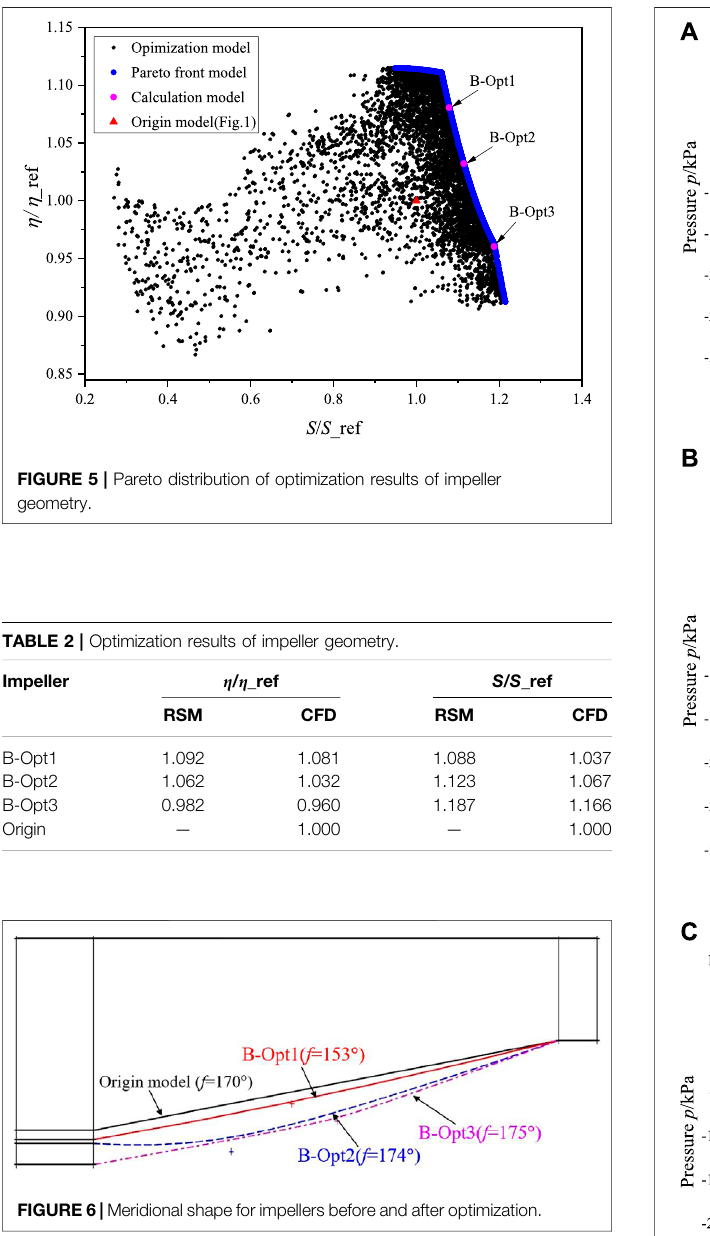
FIGURE 6| Meridional shape for impellers before and after optimization.